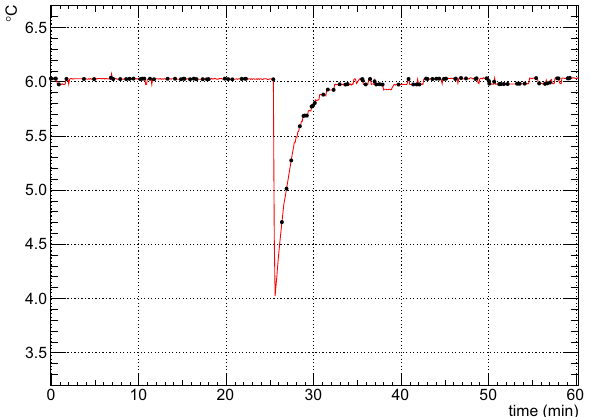
Fig. 6 Time-evolution of the superheat degree along the sudden bub- ble nucleation occurred at the vessel wall during the 90 h-long run at (cid:2) T ∼= 6 ◦ C with only background radiation. Black dots represent detected bulk volume events